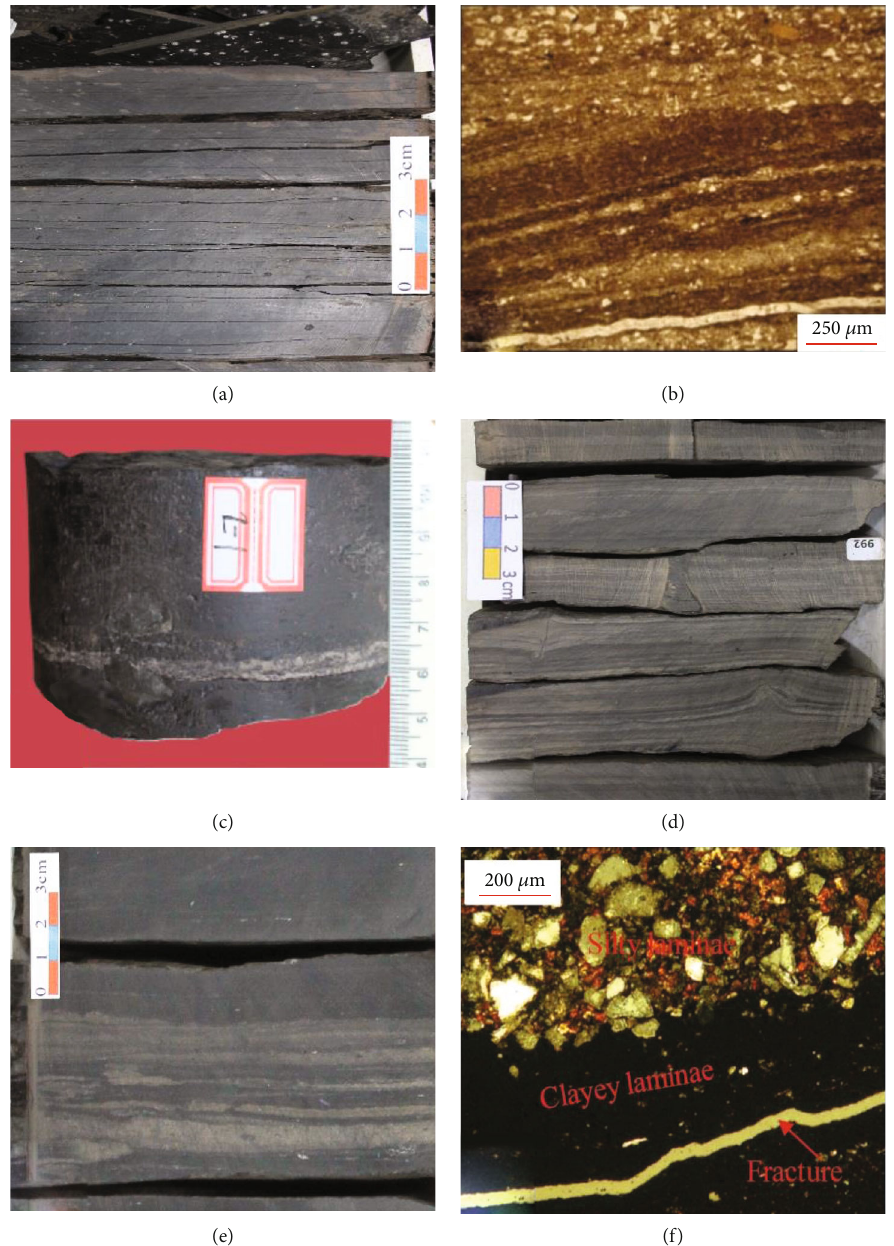
Figure 4: Lithologic characteristics of shale layers in Chang 7, Xiasiwan area. (a) 1369.11m black shale in Well Y1. (b) Silty laminated in Well Y1 1371.35m, single polarized light. (c) 1362.00m calcareous laminated in Well Y1. (d) 1370.8 m silty laminated in Well Y1. (e)